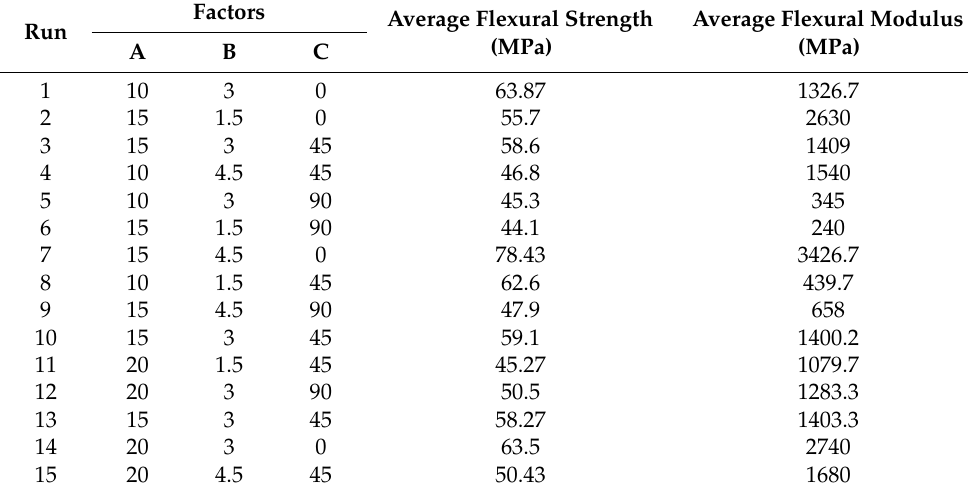
Table 4. Experimental results.